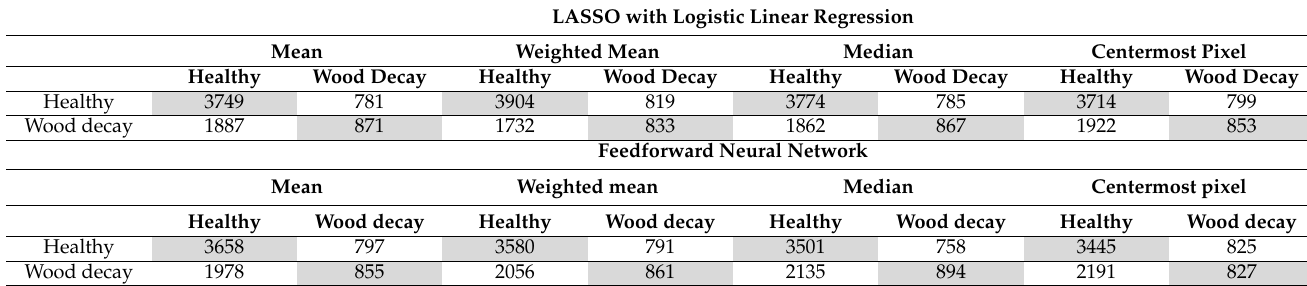
Table 2. Confusion matrices of the models with pixel aggregations for Dataset I. The cells with gray background are the main diagonal of the confusion